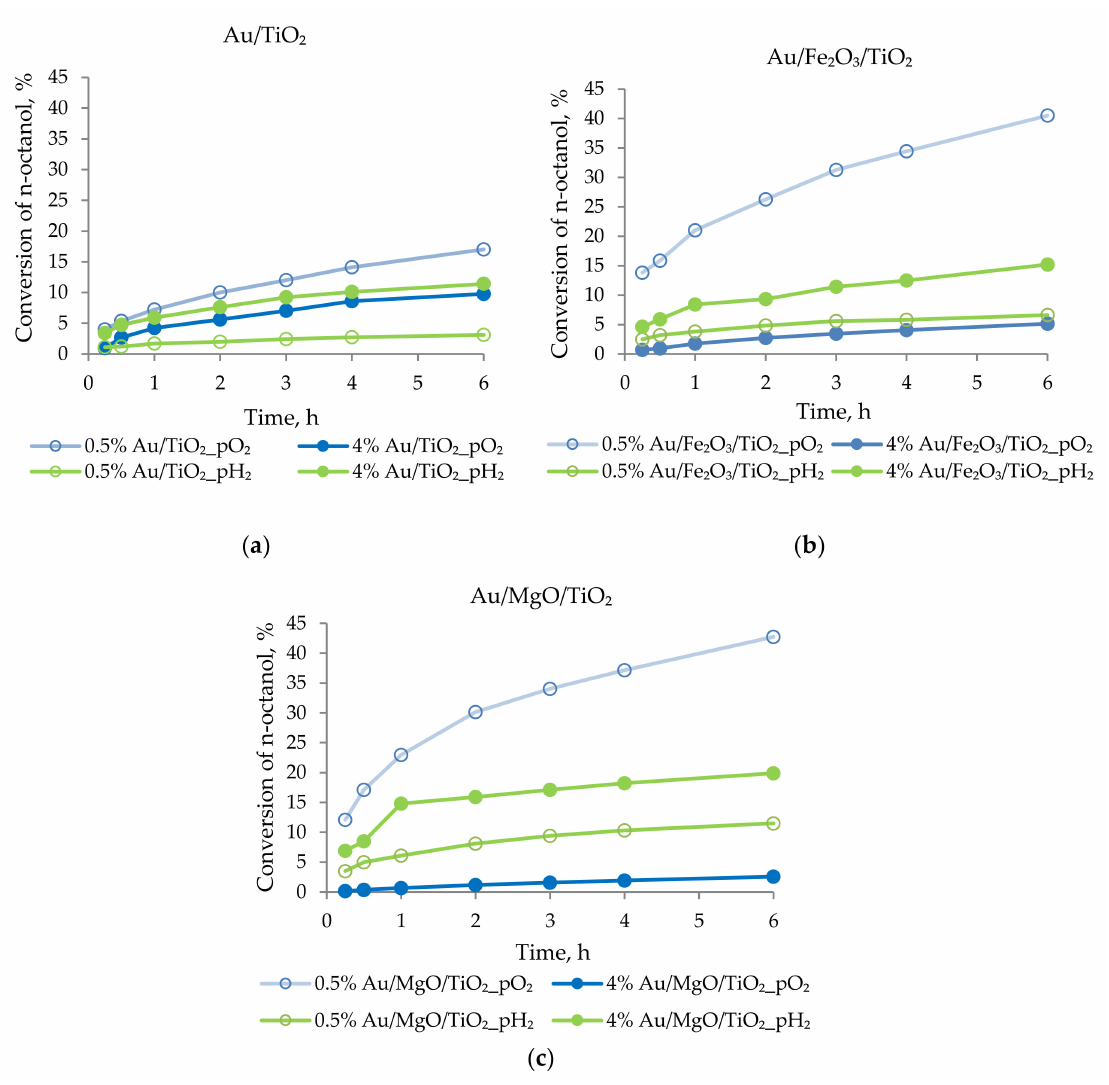
Figure 1. E ff ect of gold loading and pretreatments on the oxidation of n -octanol on Au / M x O y / TiO 2 (M x O y = Fe 2 O 3 , MgO) catalysts: evolution of conversion with run time ( a – c ). Analysis of the products distribution (Figure 2) for 0.5% Au / TiO 2 _pH 2 , 0.5% Au / Fe 2 O 3 / TiO 2 _pH 2 , 0.5% Au / MgO / TiO 2 _pH 2 samples showed that selectivity to acid formation (39%, 30% and 53% respectively) increased with run time, while selectivity to aldehyde sharply decreased from 100% at the reaction start down to 50% for 0.5% Au / TiO 2 _pH 2 , 53% for 0.5% Au / Fe 2 O 3 / TiO 2 _pH 2 and 30% for 0.5% Au / MgO / TiO 2 _pH 2 . Ester formation was at 12% and 17% levels for unmodified sample and modified samples, respectively. The selectivity trends were totally di ff erent for their homologues with 4 wt.% gold loading after hydrogen pretreatment. The main product was octanal. Octanoic acid formation was practically negligible; only some traces of acid were detected at longer run times for 4% Au / TiO 2 _pH 2 and 4% Au / MgO / TiO 2 _pH 2 . For 4% Au / Fe 2 O 3 / TiO 2 _pH 2 ; selectivity towards octyl octanoate increased at the expense of octanal formation with no acid